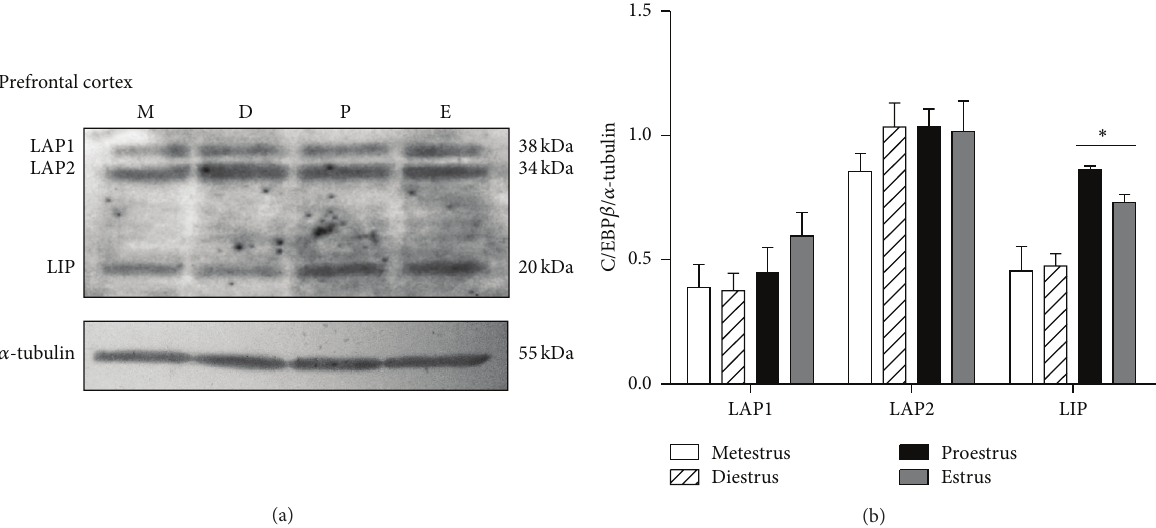
Figure 2: C/EBP 𝛽 isoforms content in the rat prefrontal cortex throughout the estrous cycle. (a) A representative western blot for LAP1, LAP2, and LIP isoforms content during metestrus (M), diestrus (D), proestrus (P), and estrus (E). (b) Densitometric analysis of LAP1, LAP2, and LIP content relative to that of 𝛼 -tubulin. The data represent the mean ± S.E.M, 𝑛 = 6 , ∗ 𝑃 < 0.05 LIP proestrus and estrus versus metestrus and diestrus.